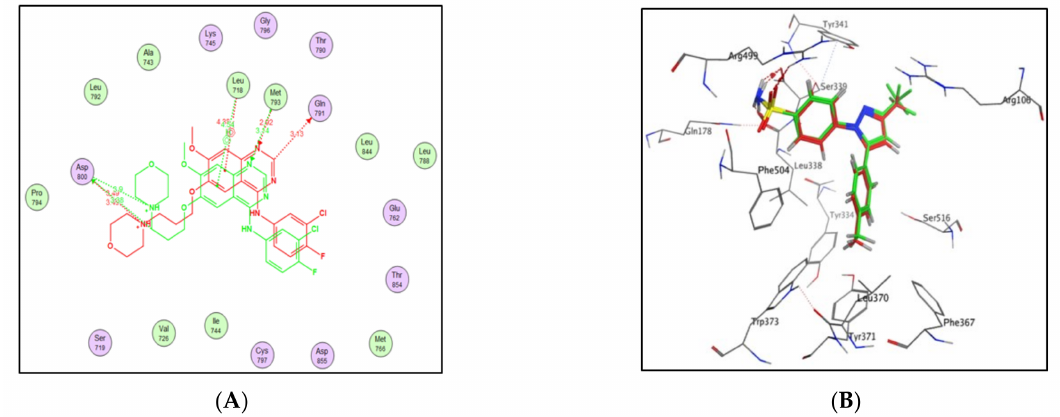
Figure 8. Two-dimensional diagram ( A ) and 3D representation ( B ) of the superimposition of the cocrystallized (red) and the docking pose (blue) of ligand (gefitinib) in the EGFR binding site with RMSD of 1.3